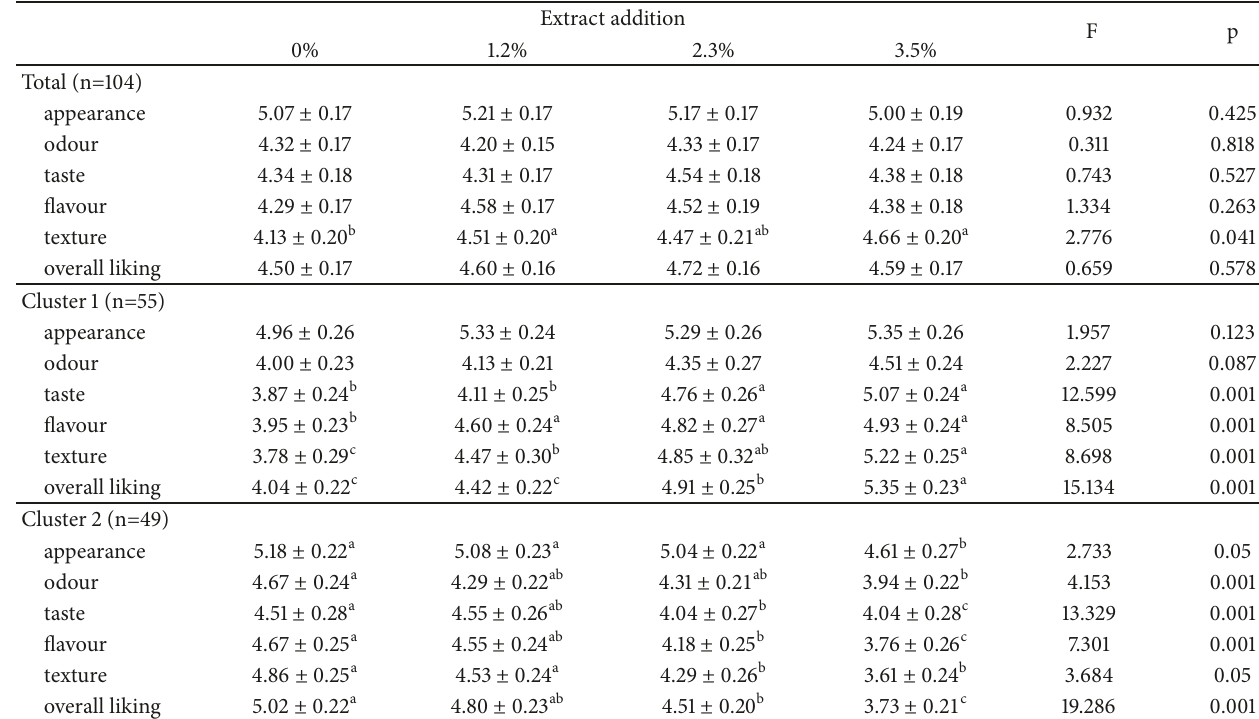
Table 4: Influence of the addition of encapsulated grape skin extract at different levels (0, 1.2, 2.3, and 3.5% on dough weight) on biscuit consumers’ preference(liking for appearance, odour, taste, flavour, texture,overall liking). Values are means ± SD. The same superscript letter inthe same rawindicatesmeans arenot statistically differentaccordingto analysis of variance (ANOVA)and post hocFishers’least significant test (p <